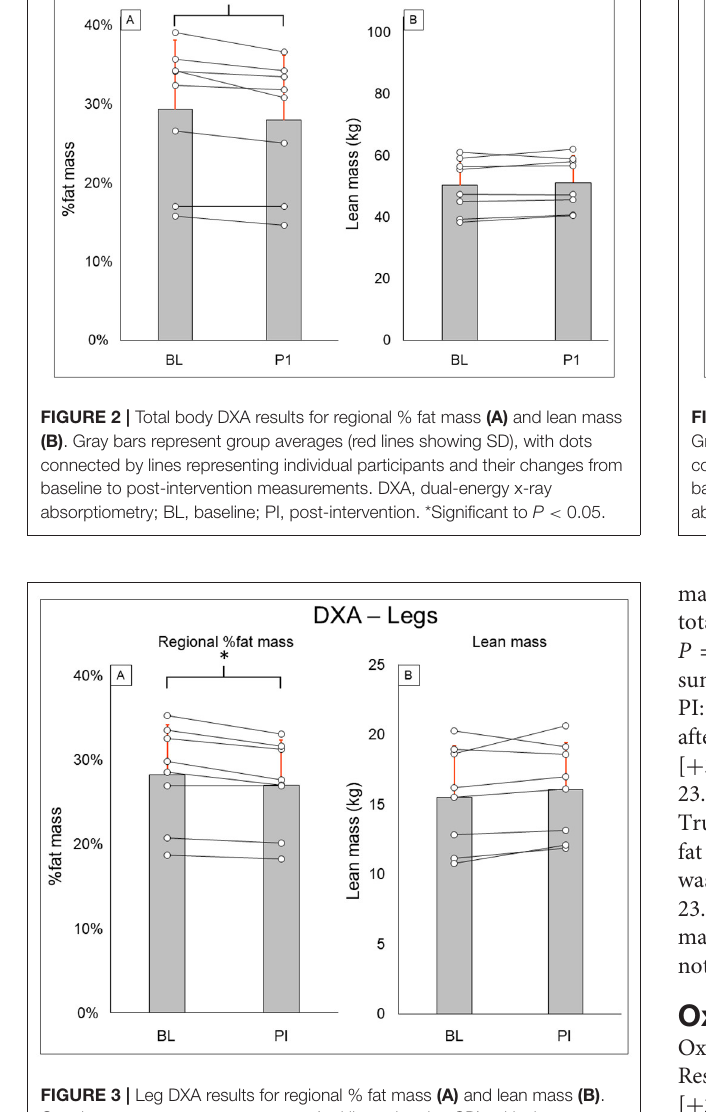
FIGURE 3 | Leg DXA results for regional % fat mass (A) and lean mass (B) . Gray bars represent group averages (red lines showing SD), with dots connected by lines representing individual participants and their changes from baseline to post-intervention measurements. DXA, dual-energy x-ray absorptiometry; BL, baseline; PI, post-intervention. *Significant to P < 0.05.